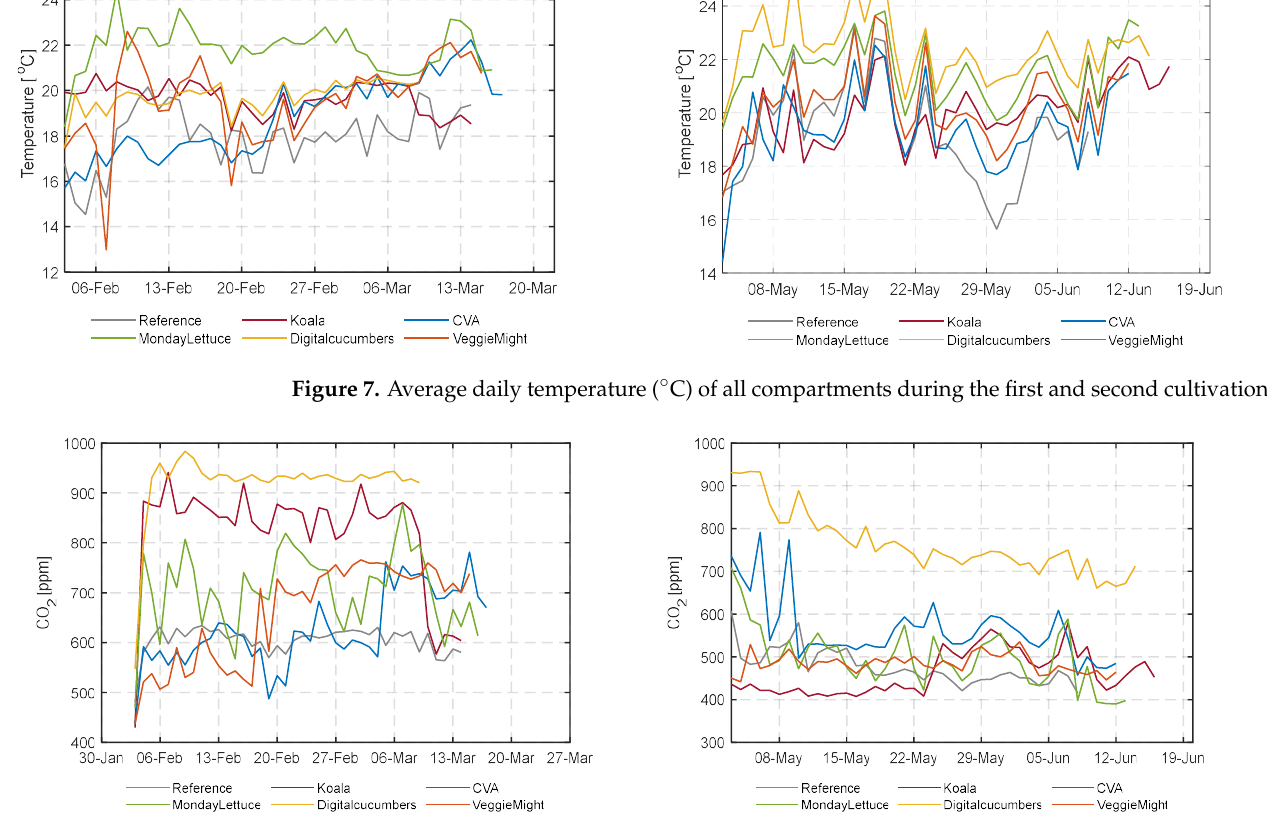
Figure 8. CO 2 concentration (ppm) for the different compartments during the first and second cultivation.